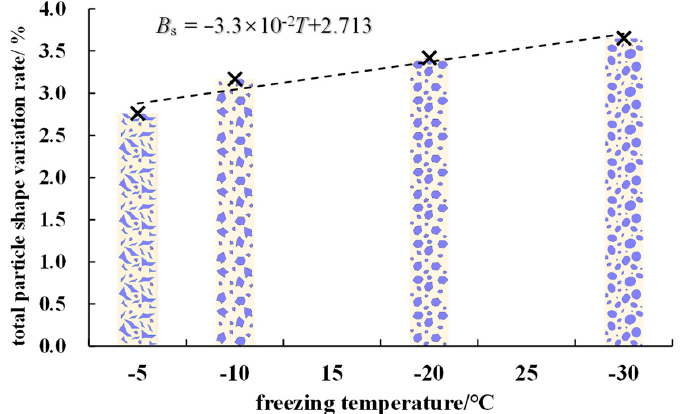
Figure 17. The effect of freezing temperature on the total particle shape of silt.